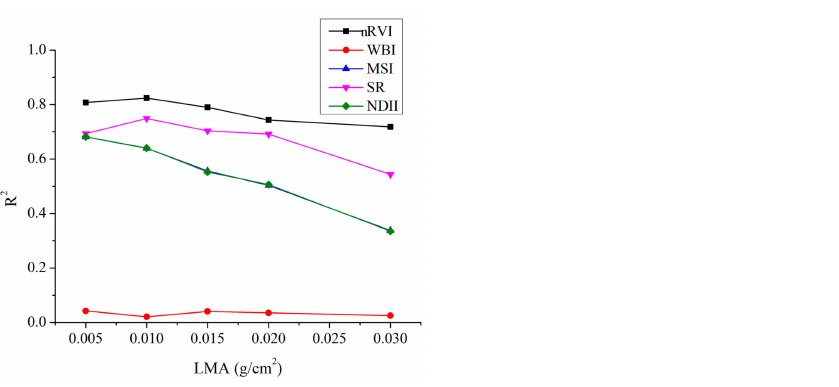
Figure 9. Accuracy of nRVI, WBI, MSI, SR, and NDII for EWT estimation across various LMA contents based on the synthetic dataset with 2% Gaussian